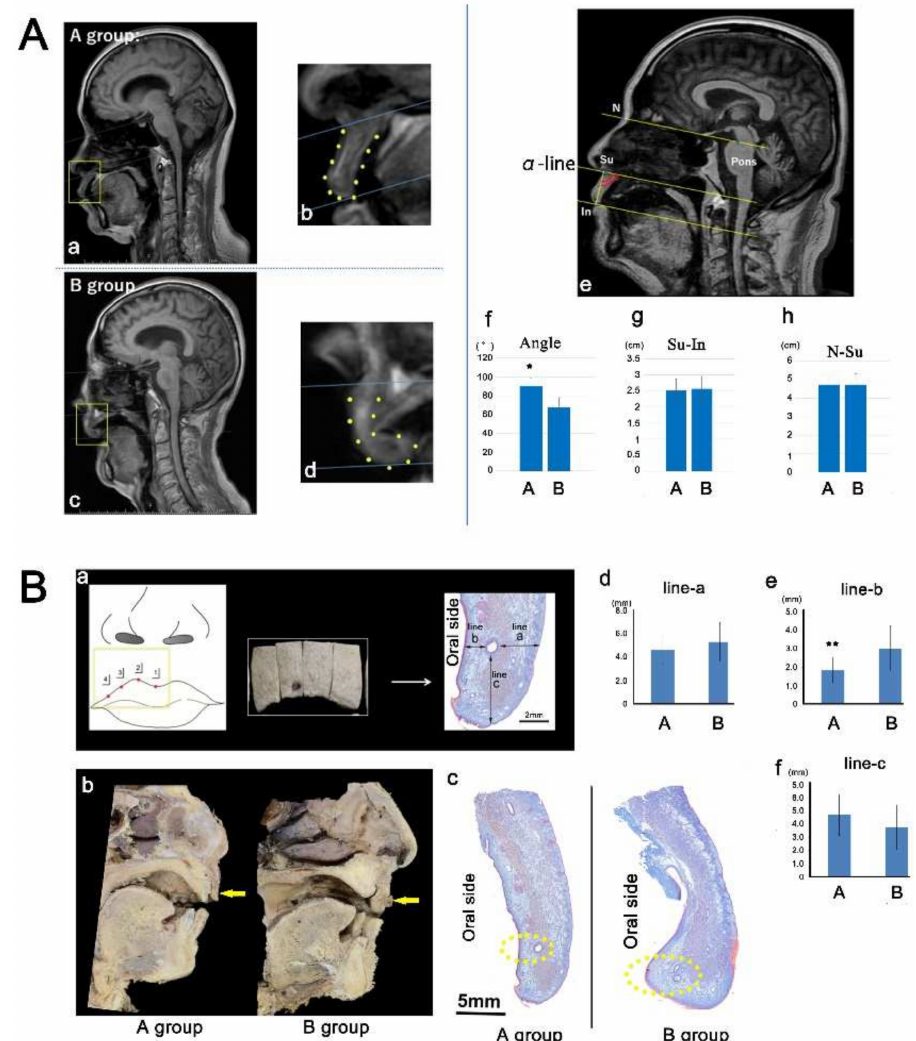
Figure 1. The morphology of the upper lip in humans: Patients and cadavers were divided into two groups based on the presence (Group A) or absence of anterior teeth (Group B). ( A ) Magnetic resonance imaging findings: The lip bent toward the oral cavity side in Group B compared with the findings in Group A (Panels a–d). The angle between the α -line and the Su–In line was smaller in Group B than in Group A (Panels e and f; * p < 0.05). The distance from Su to In, or N–Su, was not significantly different between the groups. ( B ) Cadaver findings: The lip bent toward the oral cavity side in Group B compared with the findings in Group A (Panels b and c). The length of line b revealed greater thickening of the oral mucosa in Group B than in Group A (Panels a and e; ** p < 0.01). The lengths of line a and line c did not differ between the groups (Panels a, d, and f). Su: subnasal point; In: inferior tip of the upper